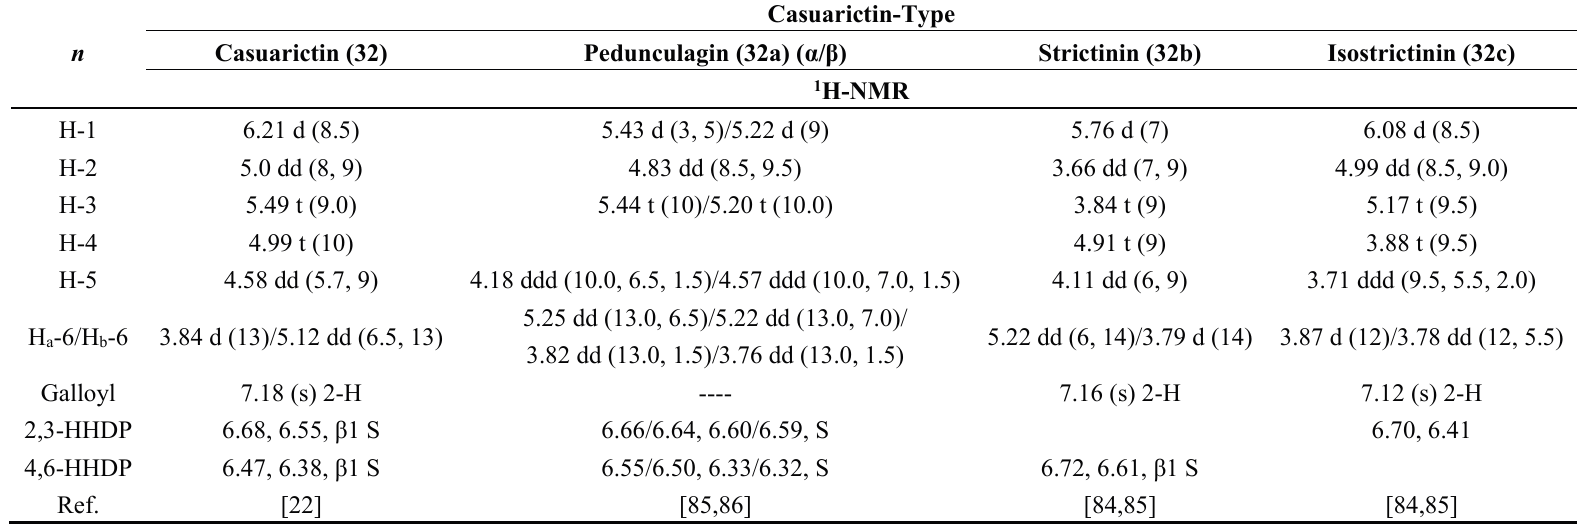
Table 2. 1 H-NMR of sugar moieties of casuarictin-type monomeric